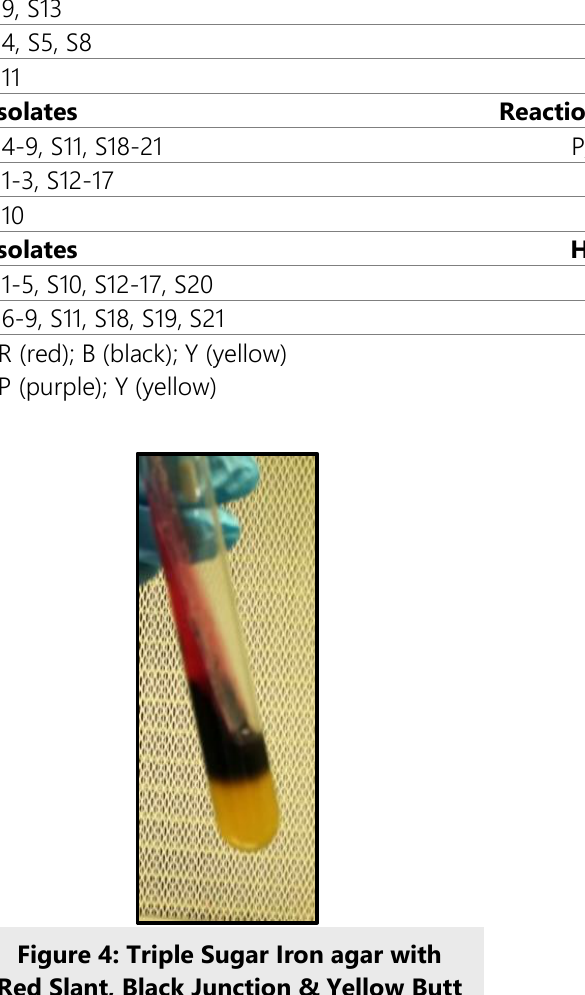
Figure 4: Triple Sugar Iron agar with Red Slant, Black Junction & Yellow Butt showing Positive Salmonella reaction